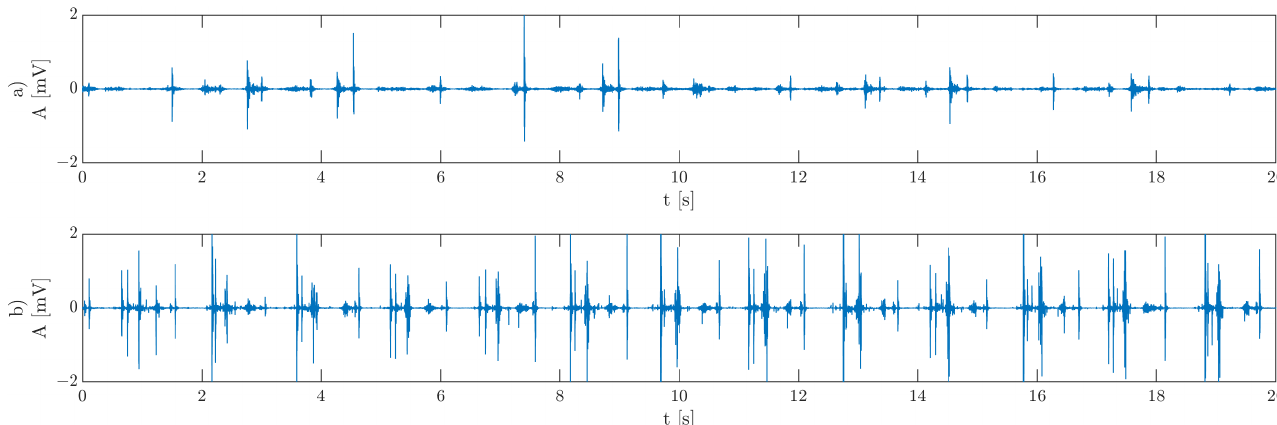
Figure 1. Exemplary VAG signal for ( a ) asymptomatic and ( b ) symptomatic temporomandibu- lar